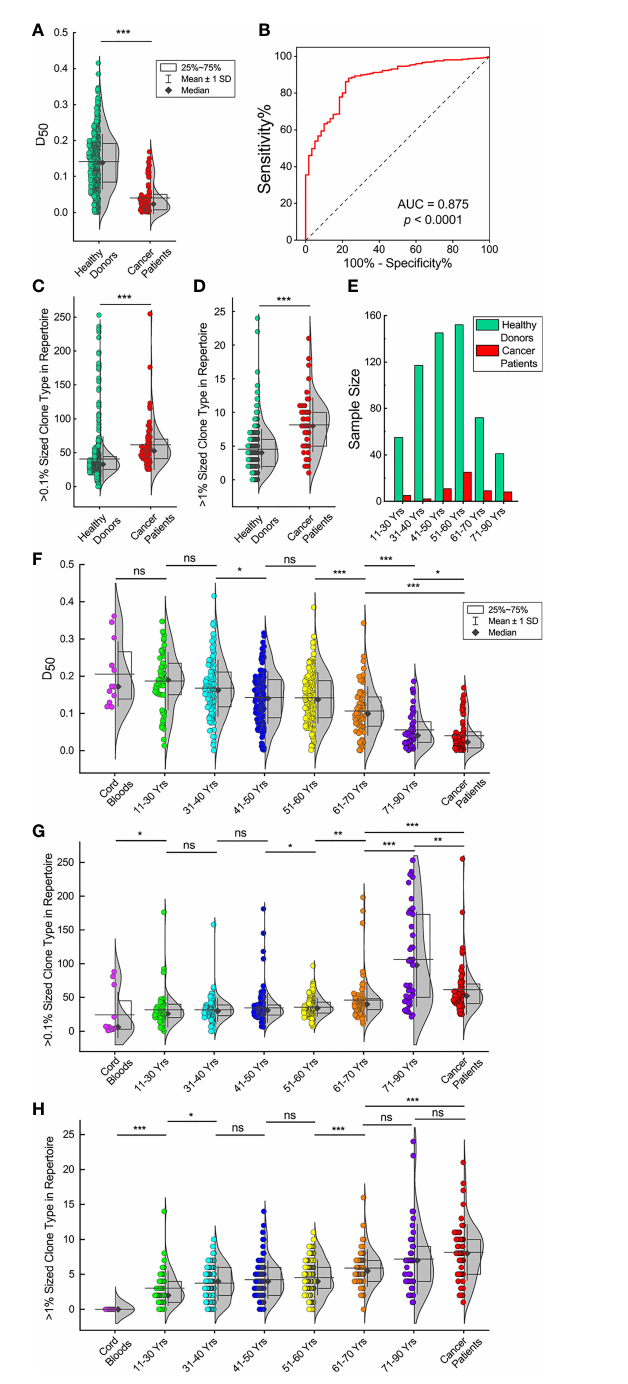
FIGURE 3 TCR b repertoires of elder individuals and cancer patients have low diversities and signi fi cant clone expansions. (A) D 50 values of 582 healthy donors and 60 cancer patients. The violin plot curve indicates distribution of the data points while the box indicates the majority data chunk (25%~75%); the vertical whiskers depict the standard deviations; the horizontal line depicts the mean value while the black diamond represents the median value (same for all following violin plots). (B) Receiver operating characteristic (ROC) curve analysis to distinguish healthy donors from cancer patients according to the D 50 values. (C, D) . TCR b CDR3 clone types that account for more than 0.1% or 1% of the repertoires for healthy donors and cancer patients. (E) Age distributions in both healthy donors and cancer patients. (F) D 50 values of healthy donors in different age groups. D 50 values of 12 cord blood samples and 60 cancer patients are also shown. (G, H) . Over 0.1% or 1% sized TCR b CDR3 clone types for healthy donors in different age groups, cord blood samples and cancer patients. The asterisks indicate p -values of the Mann-Whitney U test (* p < 0.05; ** p < 0.01; *** p < 0.001). ns, not signi fi